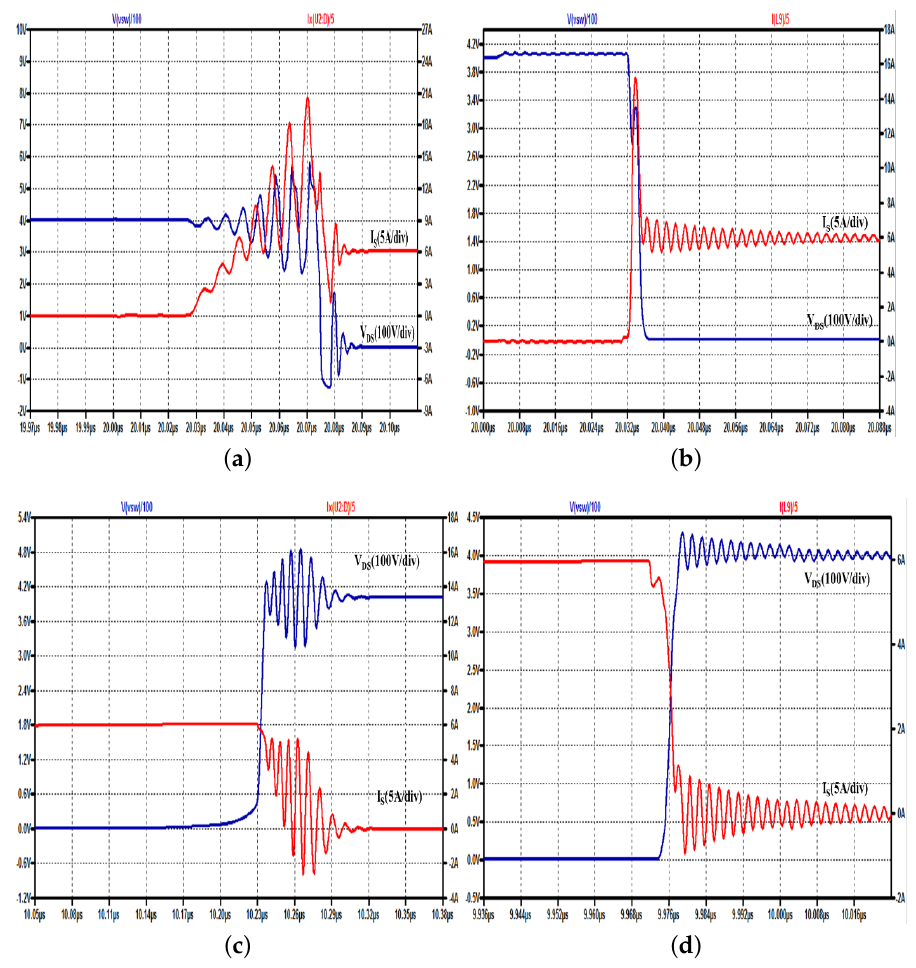
Figure 7. The turn-on and turn-off waveforms of Si MOSFET and GaN HEMT at 400 V and 30 A: ( a ) Si MOSFET Turn-on; ( b ) GaN HEMT Turn-on; ( c ) Si MOSFET Turn-off; ( d ) GaN HEMT Turn-off. Table 2. Switching